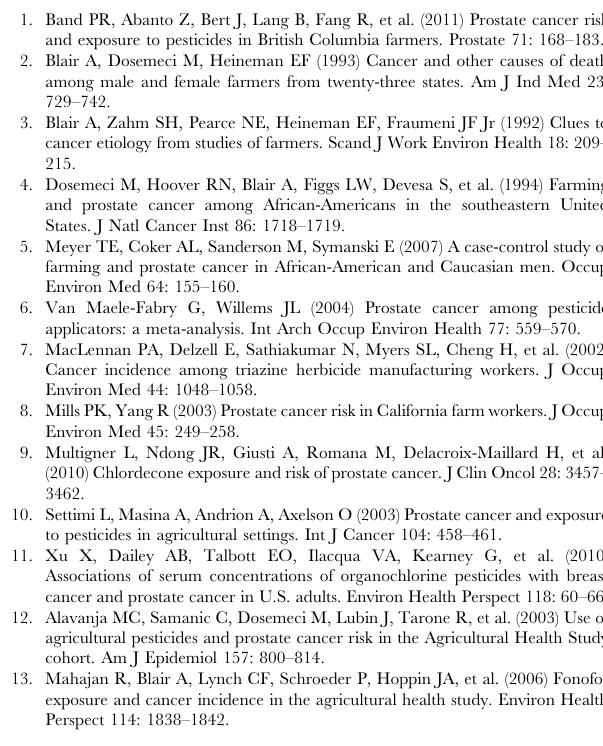
Table S1 List of 45 chemicals evaluated for